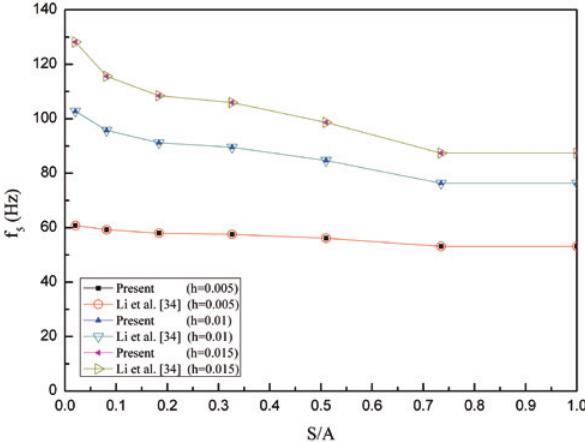
Figure 14 The fifth-order frequency of the clamped square compos- ite laminates with different area of bonding